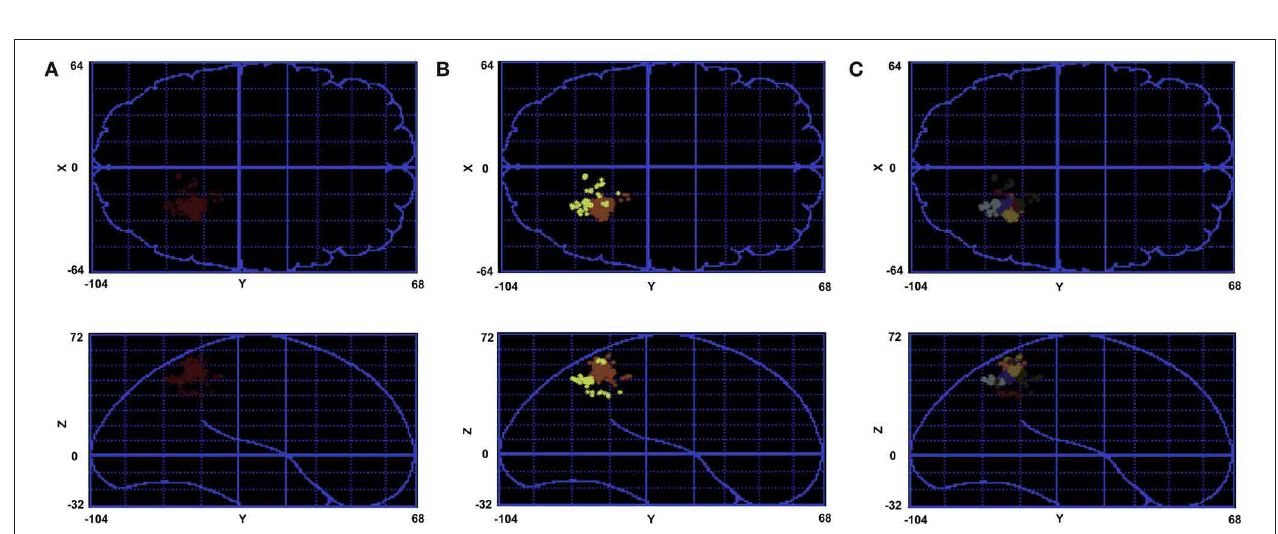
FIGURE 5 | (A) Cluster centers (red dots) resulted from the Affinity Propagation algorithm for subject 1. All the peaks have been given the same chance to become exemplars. White dots are the regions with spatial peak